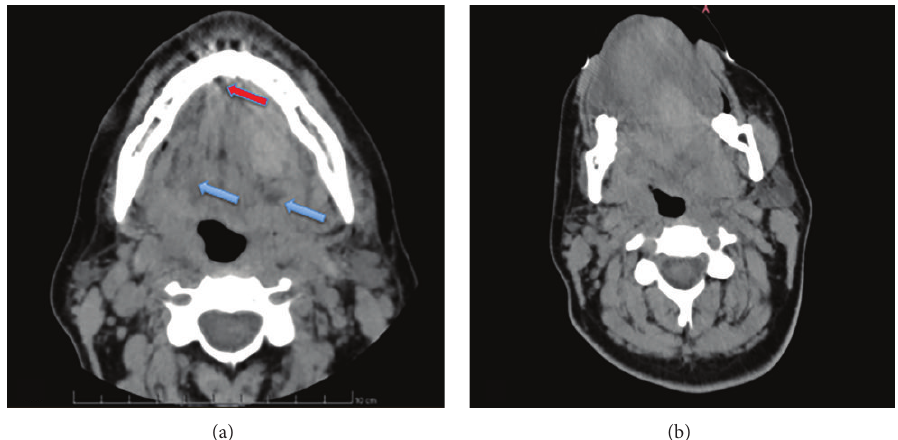
Figure 3: (a) Axial computed tomography image showing multiple areas of the whole mouth floor with different density (blue arrows) and the region of the cortical bone perforation (red arrow). (b) Axial computed tomography image showing the lingual, sublingual, and parapharyngeal haematoma with tongue displacement and restriction of the upper airways spaces.